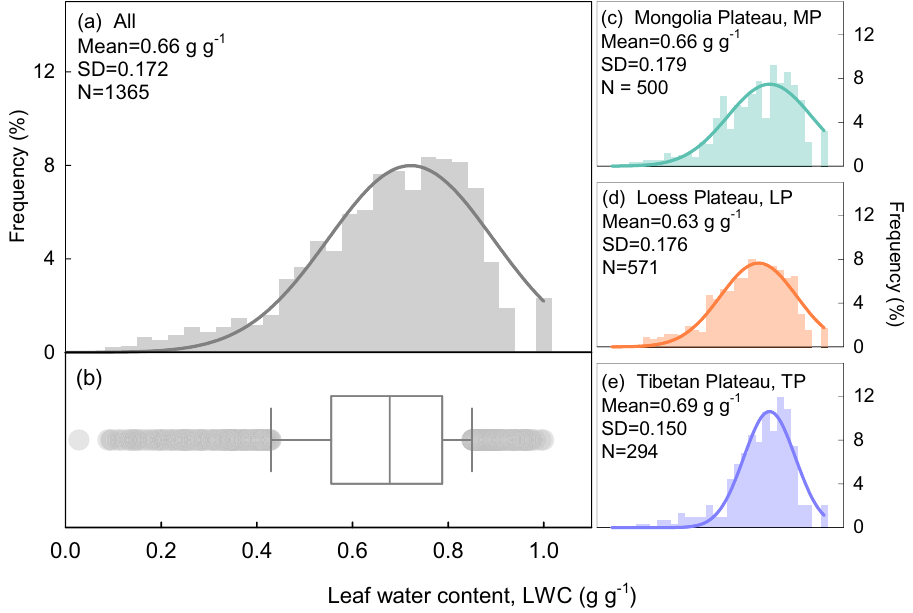
Figure 1. Frequency distribution of leaf water content (LWC) for 1365 species on three plateaus. Panels ( a ) and ( b ) present all species, and panels ( c – e ) present species from the Mongolia Plateau, Loess Plateau, and Tibetan Plateau,